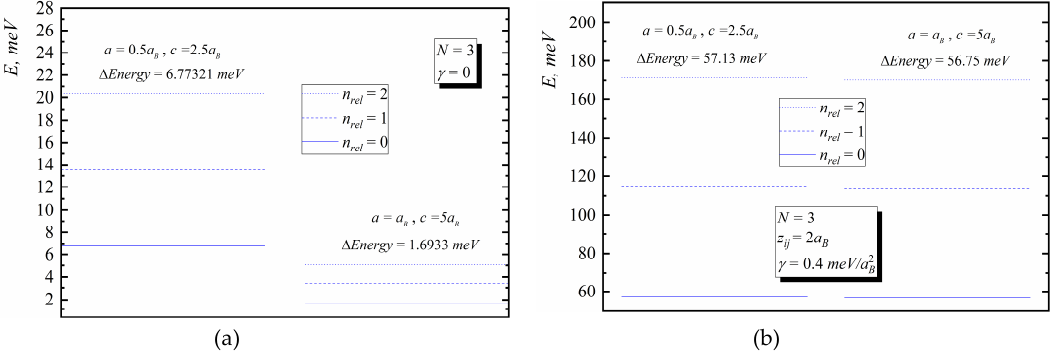
Figure 3. Energy diagram (( a )—without interaction, ( b )—with interaction) for relative motion for three-particle case for the following values: I. a = 0.5 a B , c = 2.5 a B , II. a = a B , c = 5 a B .